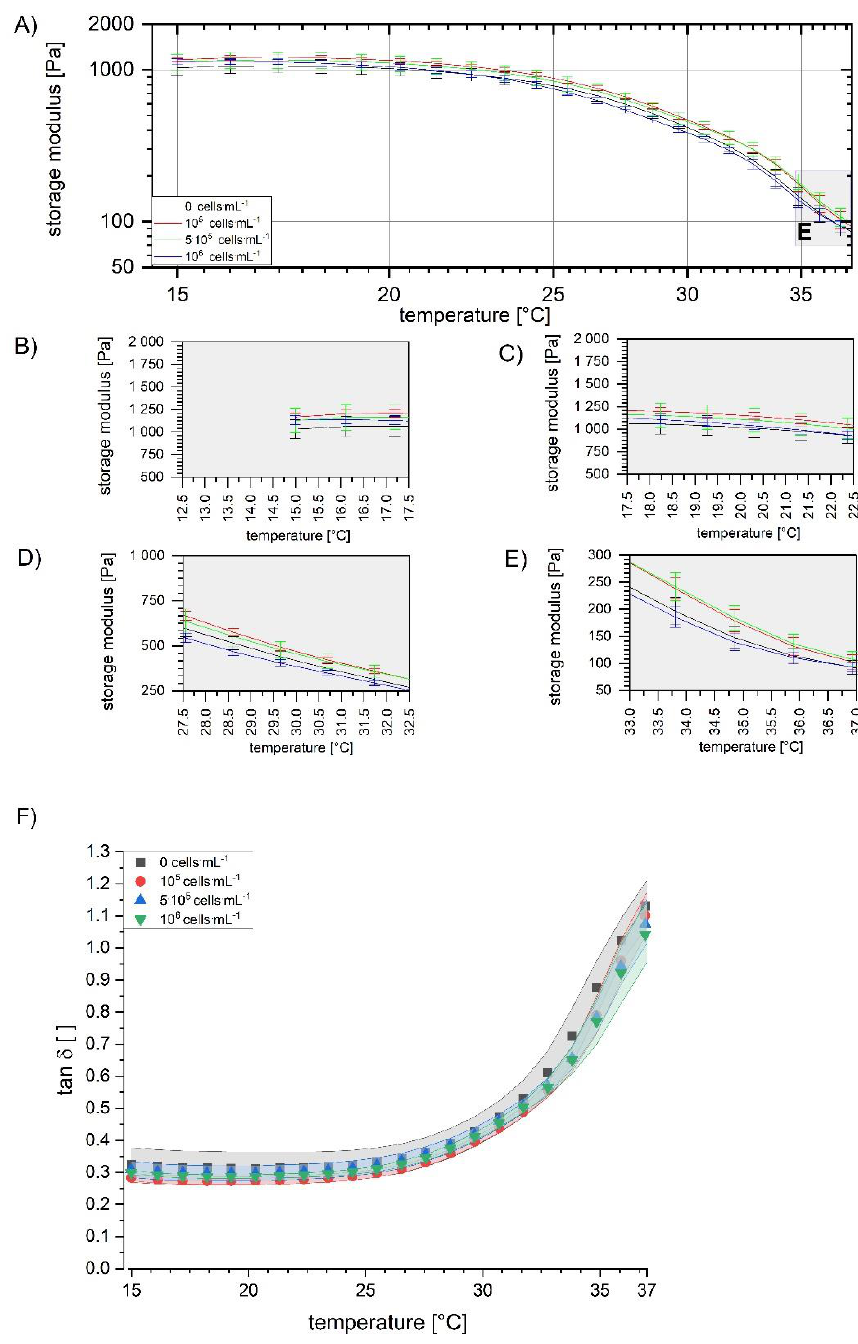
Figure 7. Temperature-dependent gel strength of the carrier material and cell-laden bioinks. The carrier material is shown in black and the bioinks in red (10 5 cells·mL −1 ), green (5·10 5 cells·mL -1 ), and blue (10 6 cells·mL −1 ). ( A ) The overall temperature sweep for the samples in oscillation mode. ( B – E ) Zoomed segments of the temperature curve. ( F ) The corresponding loss factors. Data are means ± SD ( n = 3).